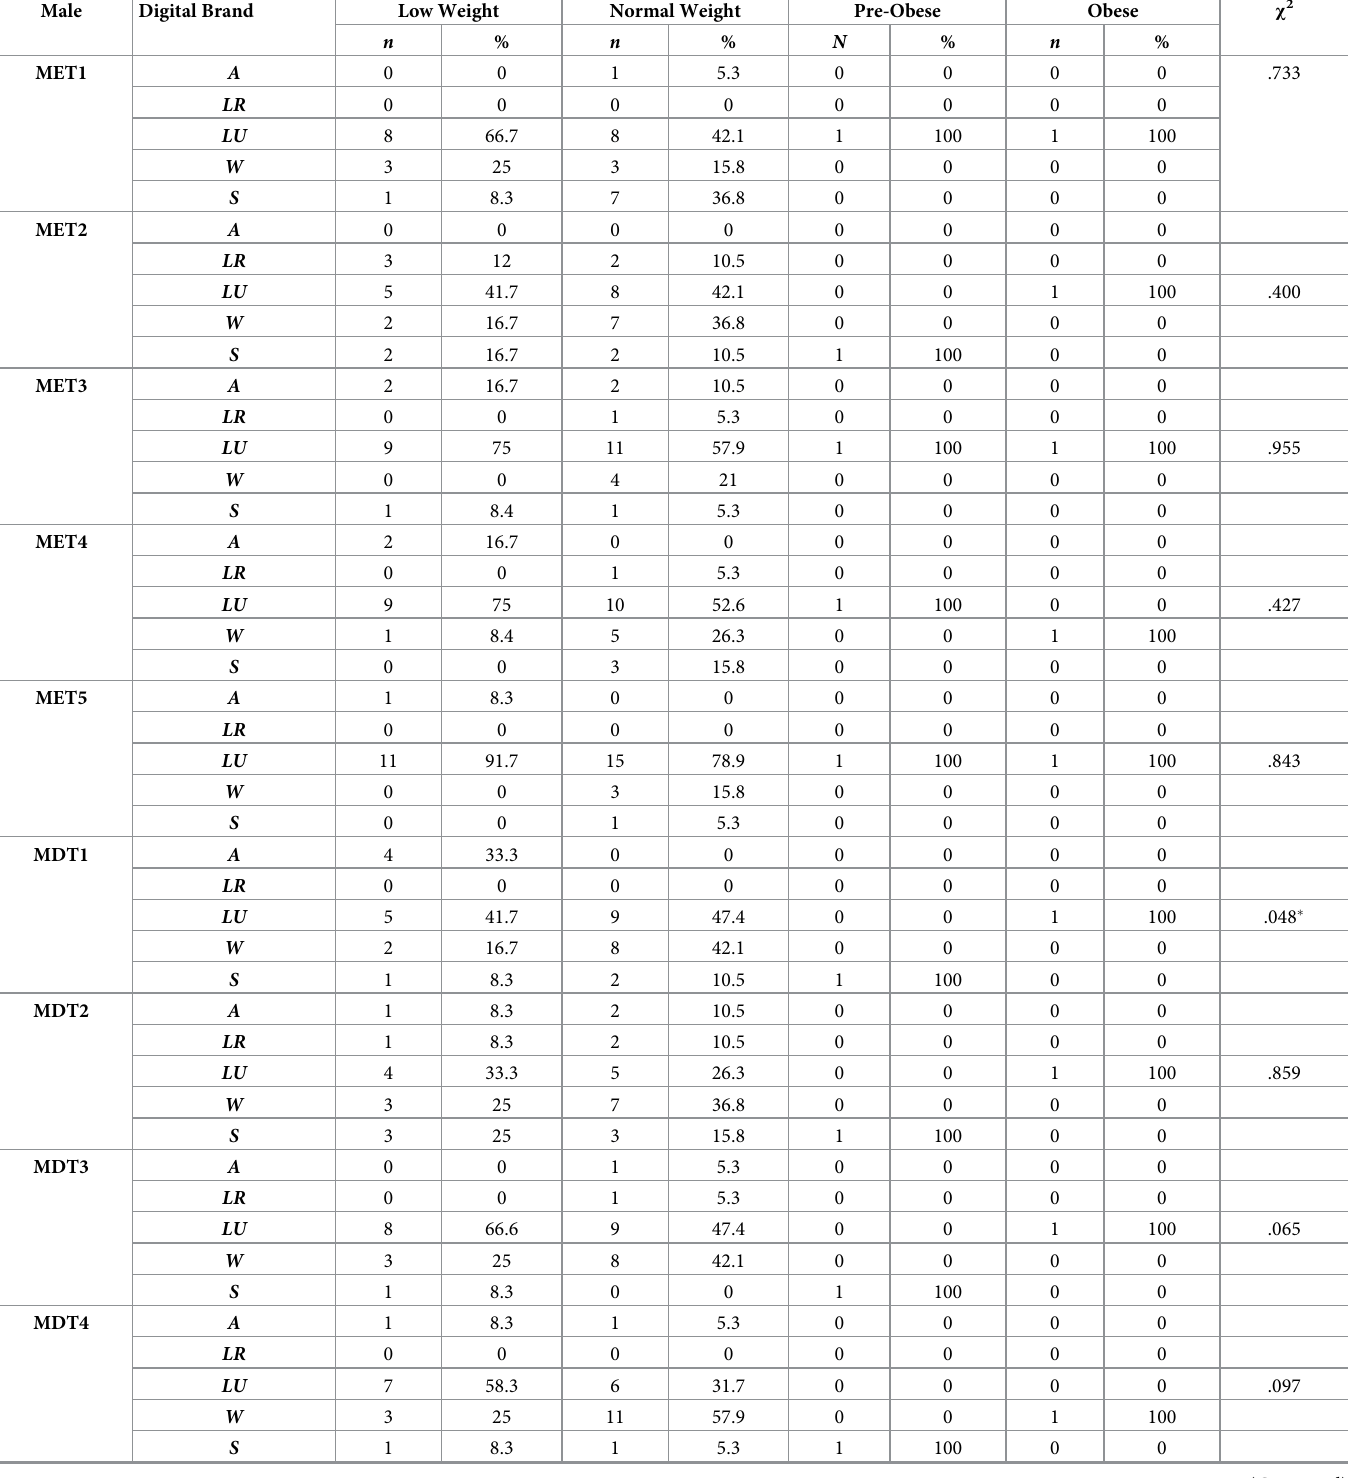
Table 6. Relationship between BMI child and digital